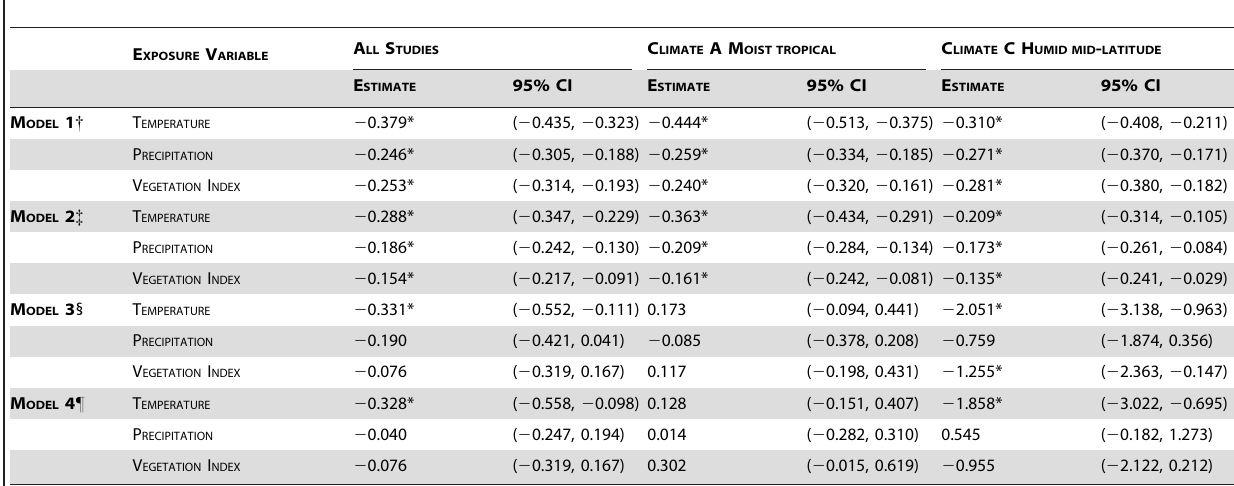
Table 3. Regression parameters and confidence intervals for Models 1–4 for all studies and by climate category (analysis was not conducted for Climate B because there was only one location in this